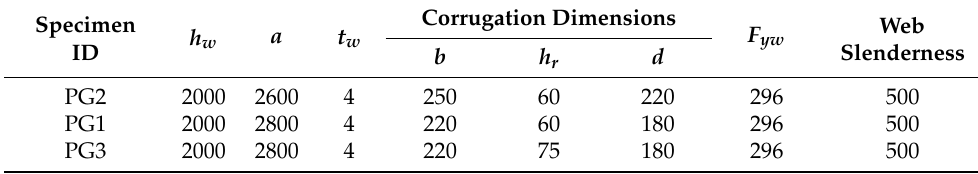
Table A7. Data of specimens tested by Moon et al.